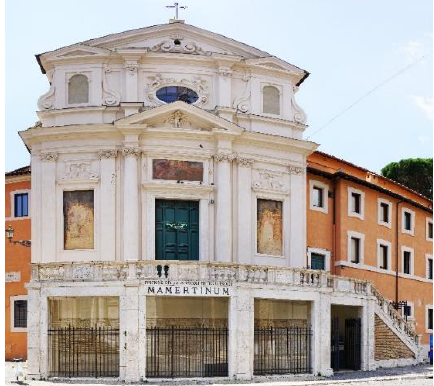
Figure 20. Spherical panorama of San Giuseppe dei Falegnami.